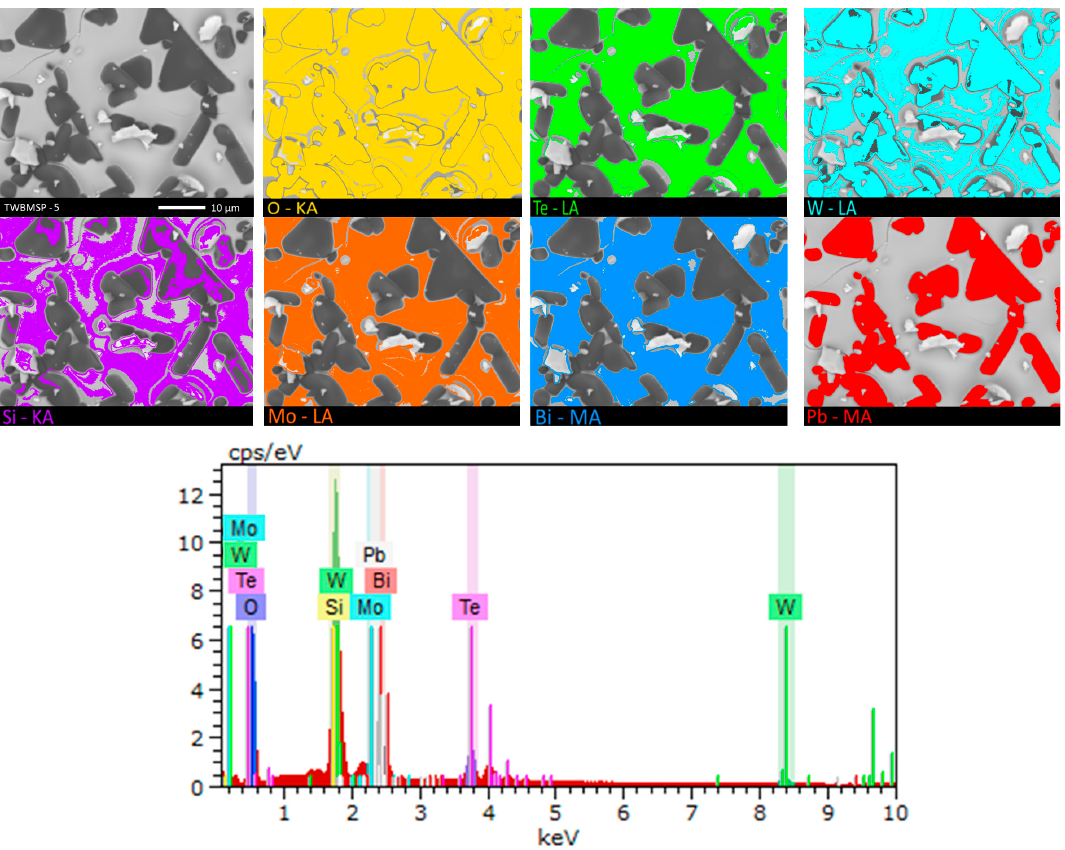
Figure 3. Mapping results for TWBMSP-0.